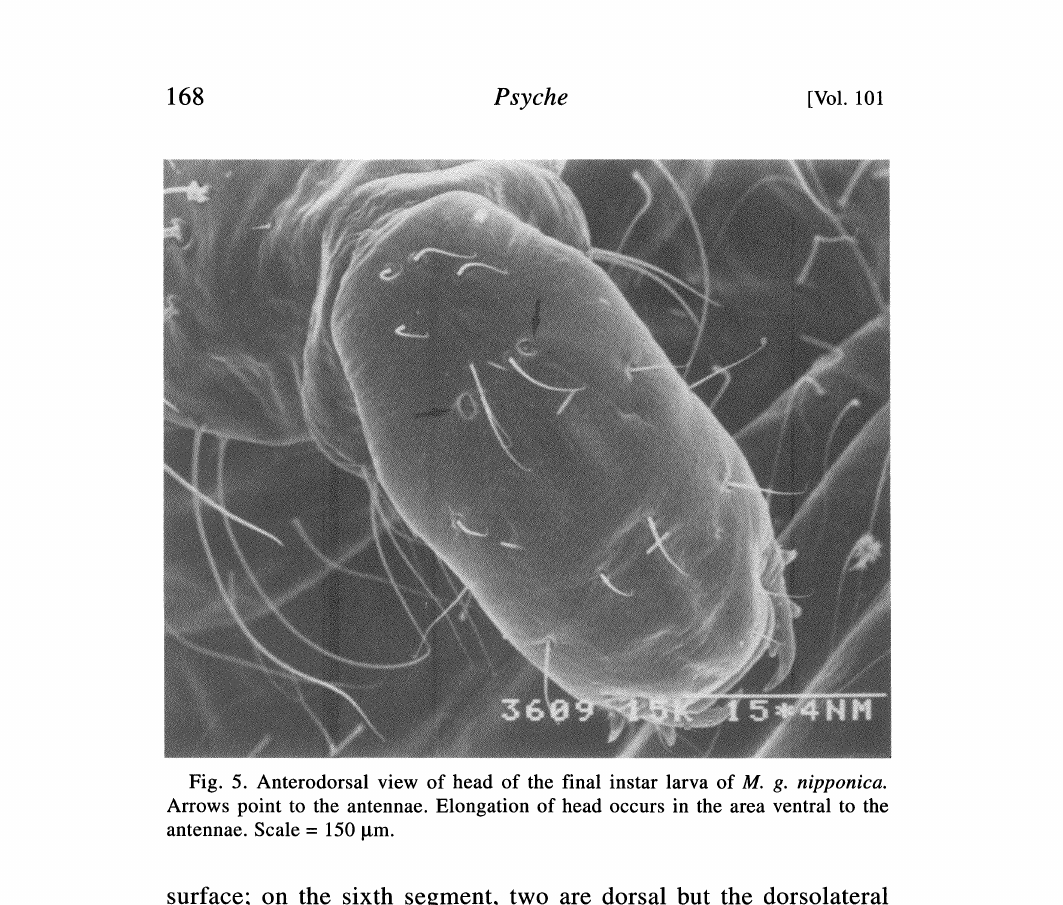
Fig. 5. Anterodorsal view of head of the final instar larva of M. g. nipponica. Arrows point to the antennae. Elongation of head occurs in the area ventral to the antennae. Scale 150